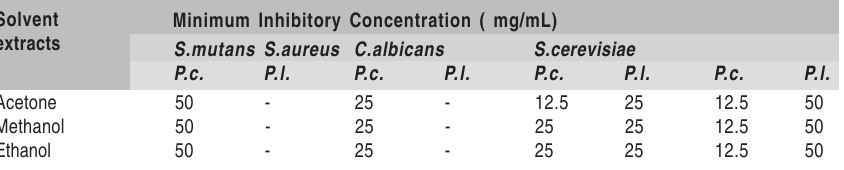
Table 2. MIC of P.cubeba and P.longum fruit extracts against oral pathogens on specific media for each microorganism determined by modified agar well diffusion